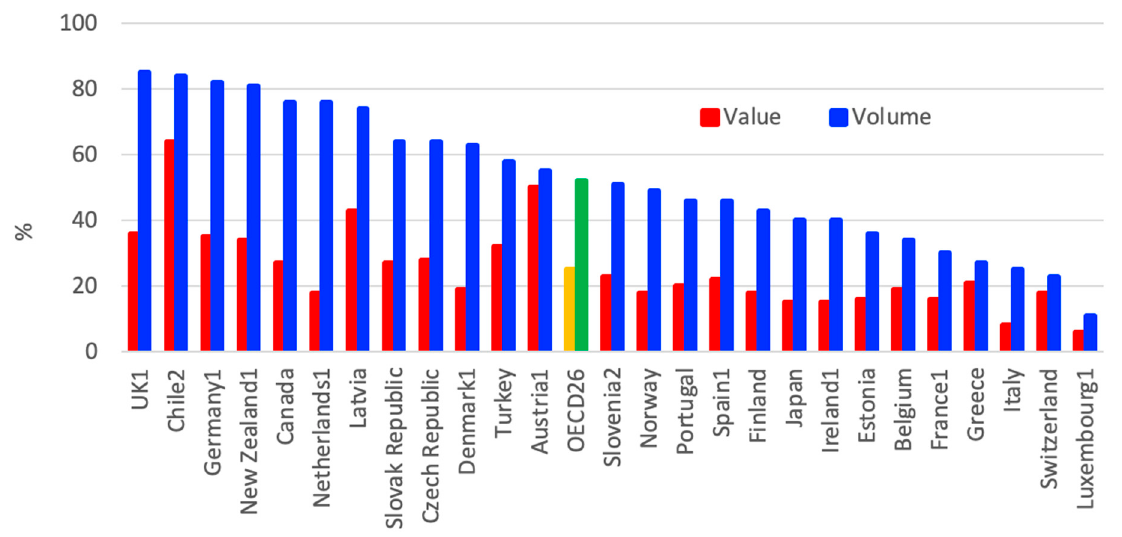
Figure 16. Consumption of generic pharmaceuticals in the OECD countries in 2017. (1) Reimbursed pharmaceutical market. (2) Community pharmacy market [3].